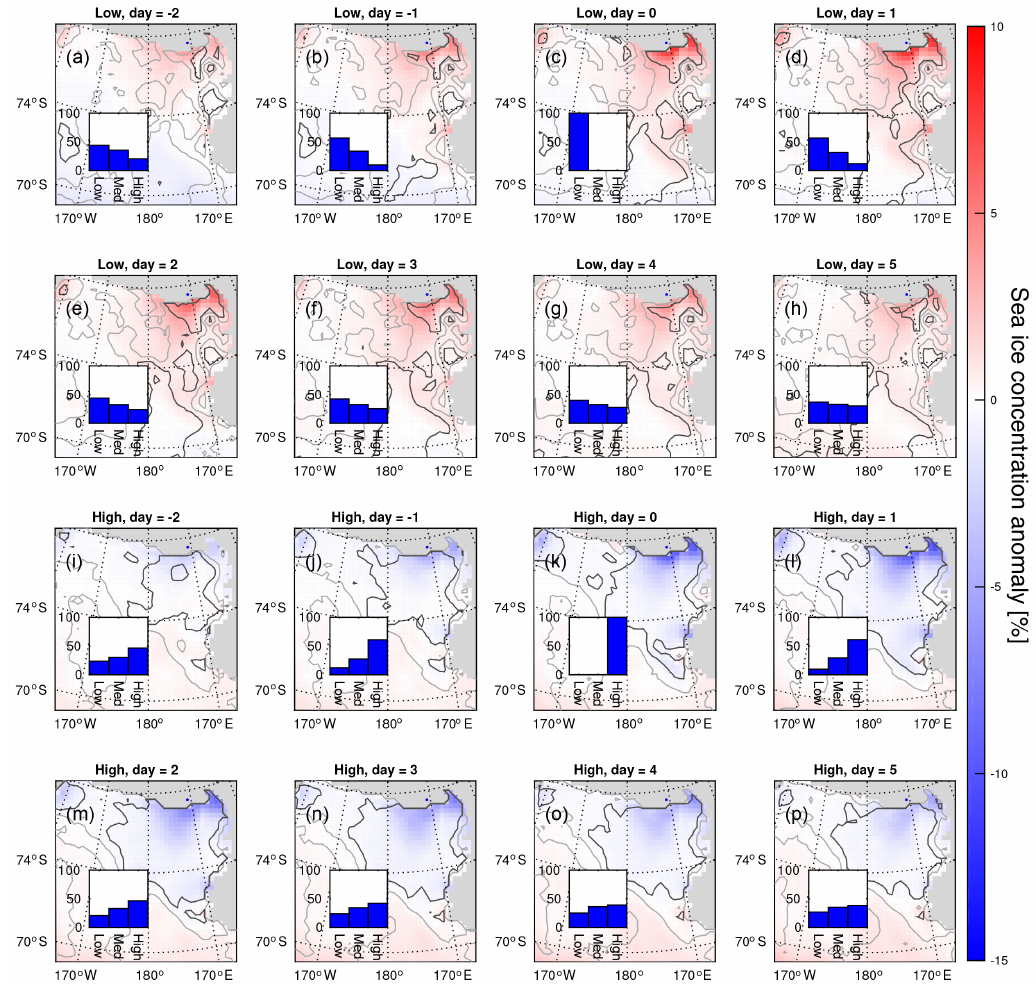
Figure 6. Composites of 2000–2014 sea ice concentration anomaly at varying delay for low-wind cases (a–h) and high-wind cases (i–p) . The grey and black contours indicate 80 and 99% significance, respectively. The inset histograms indicate the percentage of the three wind cases that occur at the respective